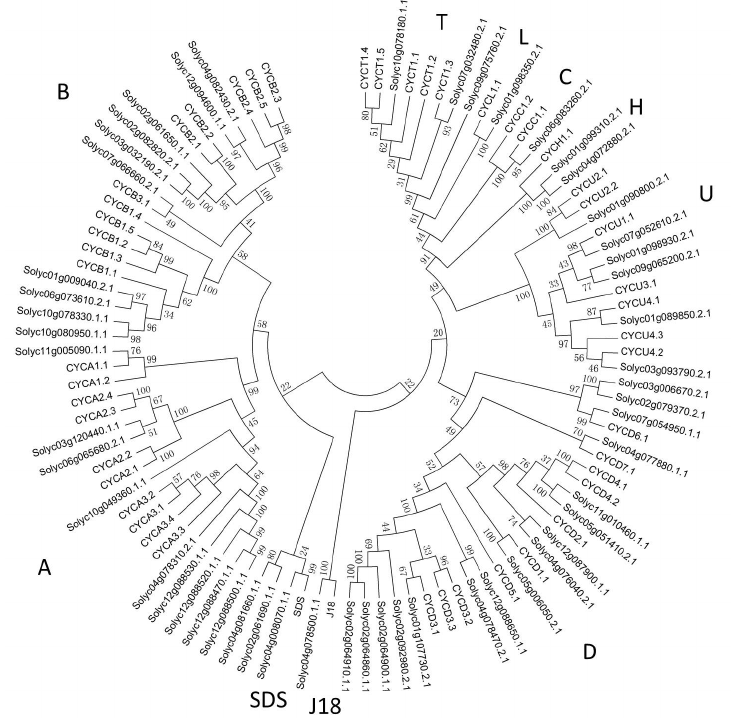
Figure 1. NJ tree of Tomato and Arabidopsis cyclins. The cyclins with “Soly” designations are from tomato. The remaining cyclins are from Arabidopsis